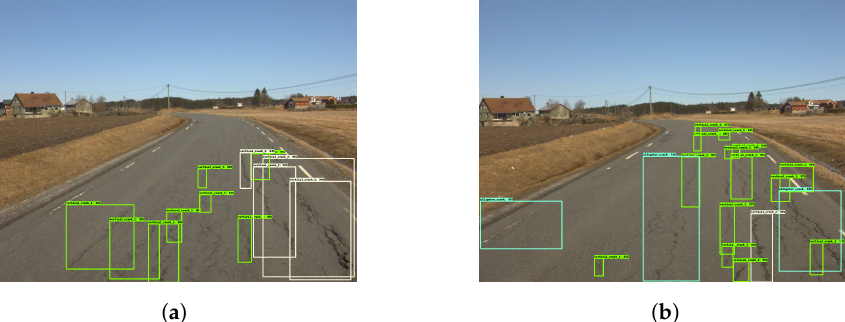
Figure 10. Cluttered detection—Model 2. The green and yellow boxes represent the vertical cracks while cyan colored boxes are the horizontal cracks.